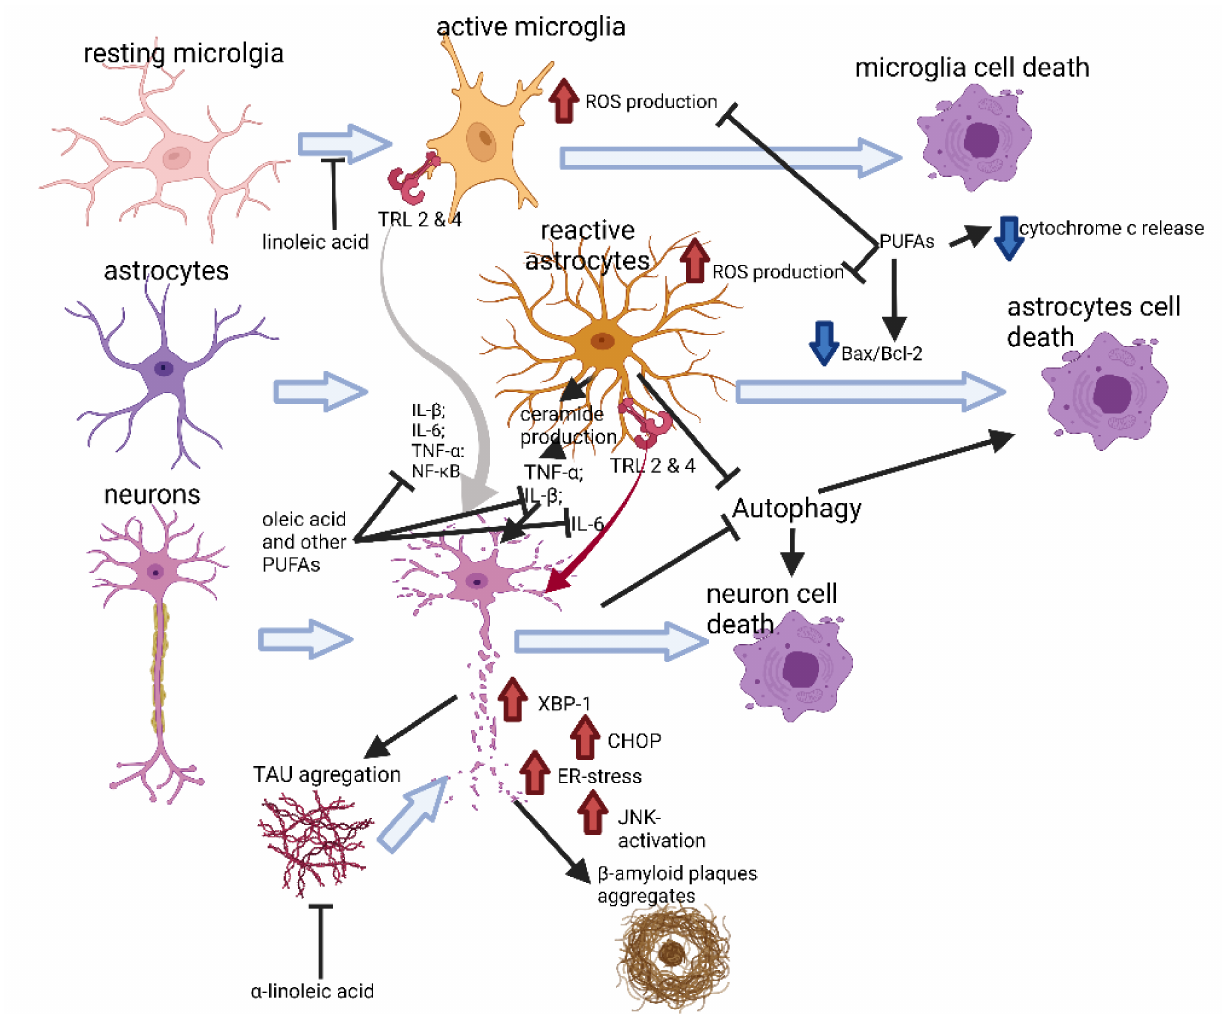
Figure 1. Graphical abstract. This figure shows some of the most reported mechanisms of damage in the different cells of the brain and how it affects neurons, revealing that neurons are prone to cell death due to an increase in the concentration of PA, followed by microglia, and the most resistant cells to PA are the astrocytes, which require higher concentrations of PA to induce cell death. Additionally, this figure shows that, at concentrations where neurons are damaged, astrocytes and microglia are turning more reactive, favoring the production of ROS, ceramides, and pro-inflammatory cytokines, among other pathways that will be explained throughout the manuscript, that will lead to positive feedback, accelerating the damage to the neurons, and promote the formation of the hallmarks of NDs in neurons. The figure also shows the modulation of these deleterious effects using other fatty acids, such as PUFAs, that showed promissory responses for attenuating the damage caused by PA, reducing the inflammatory response, ROS production, cell death, and the induction of pro-apoptotic pathways. Created with